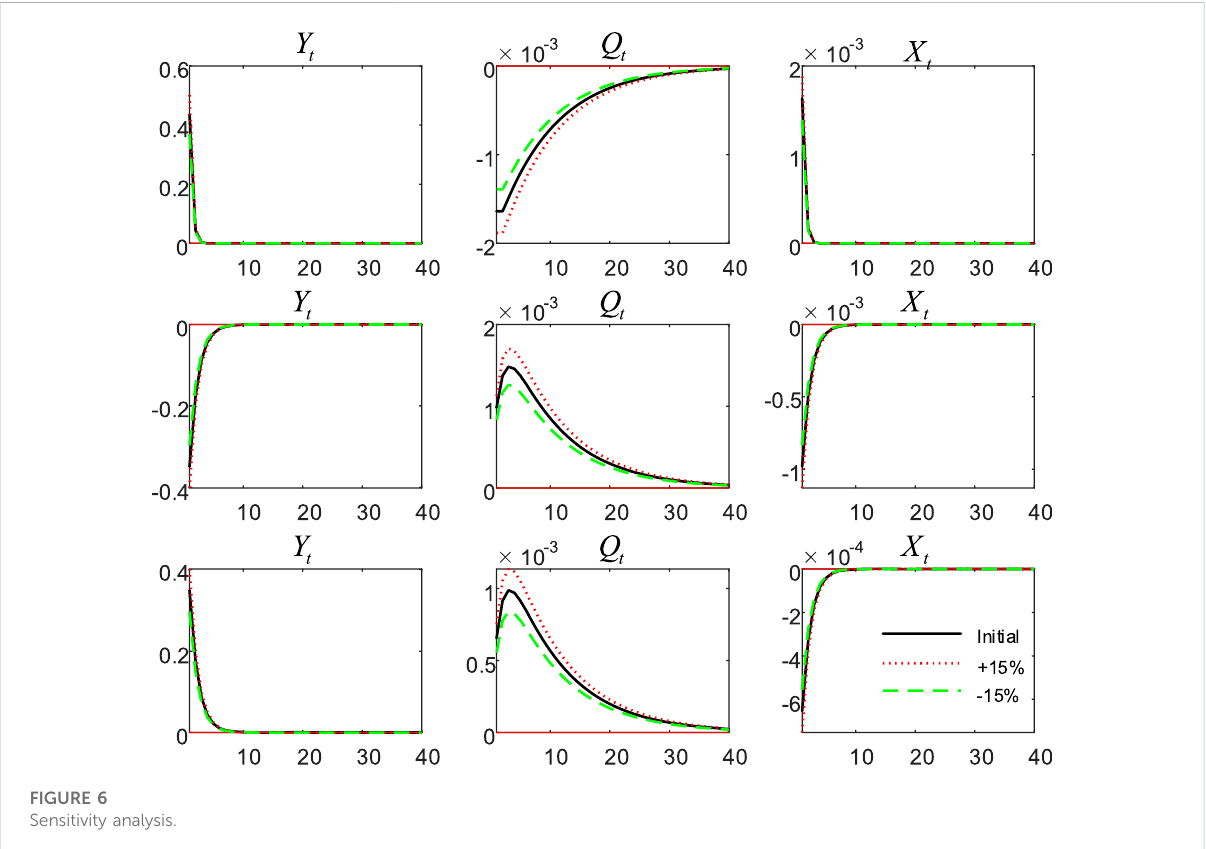
FIGURE 6 Sensitivity